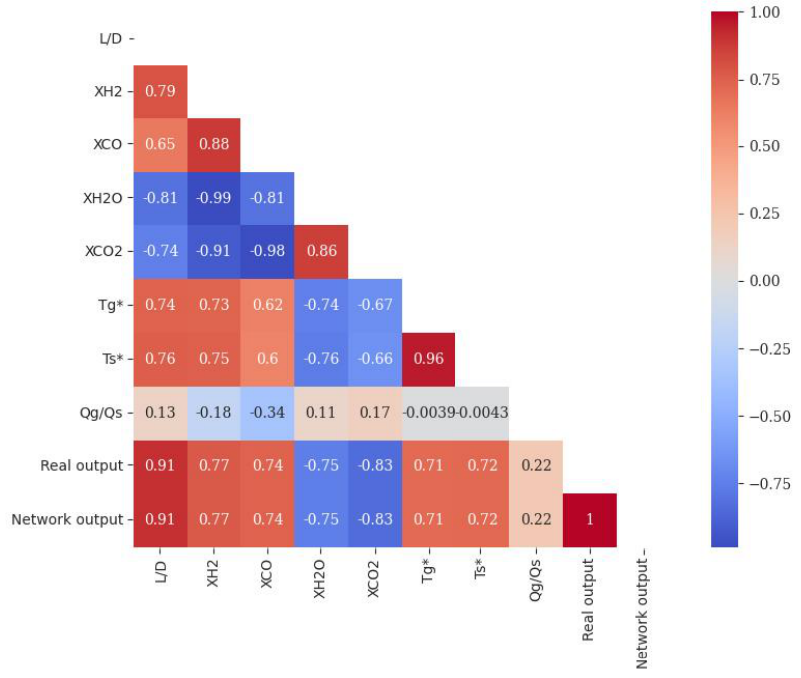
Figure 14. Heatmap of Pearson correlation coefficient matrix for network MLP.